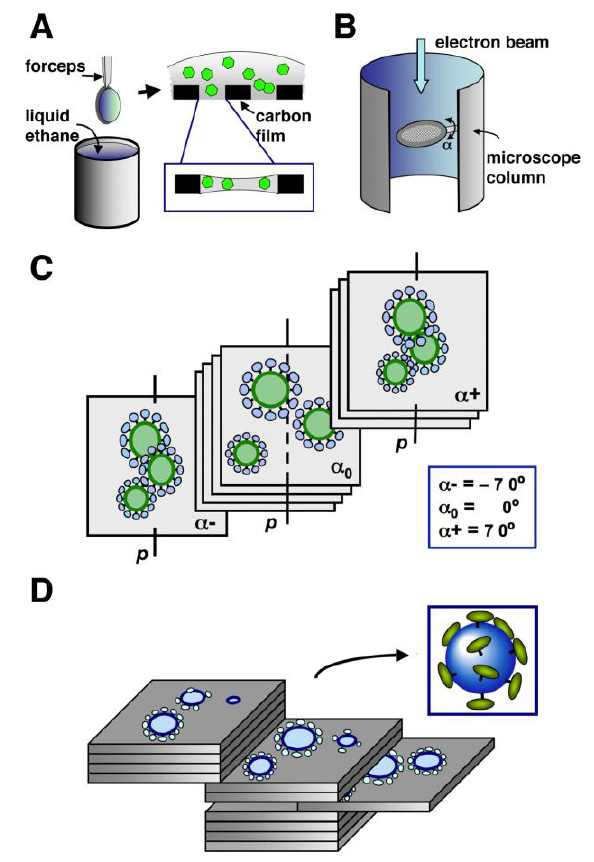
Figure 4. Cyro-electron microscopy (cryo-EM) and cryo-electron tomography (cryo-ET). ( A ) Preparation of frozen hydrated cryo-EM grid. A small aliquot (~3 µL) of specimen is added to a perforated carbon TEM grid. The grid is blotted by a filter paper and is quickly plunged into liquid ethane. The water in the specimen forms vitreous ice that is suspended across the holes of the perforated carbon film. The inset panel shows virus particles (green hexagons) embedded in the vitreous ice (grey). ( B ) Position of the TEM grid relative to the electron microscope column. The specimen holder in the microscope is perpendicular to the electron beam. The TEM grid can be rotated between −70° to 70° (α angle) around the tilt axis of the specimen holder. ( C ) A diagram showing a set of images of three virus particles (green) recorded at various α tilt angles (inset). ―p‖ represents the position of the specimen holder tilt axis in each image. ( D ) Three-dimensional (3D) reconstruction map and an extracted model of one virus particle. The reconstruction map is represented as a set of two-dimensional slices, which cut through the 3D map of the virus particles (blue). The 3D model of any virion (inset) can be extracted from the reconstruction map for further